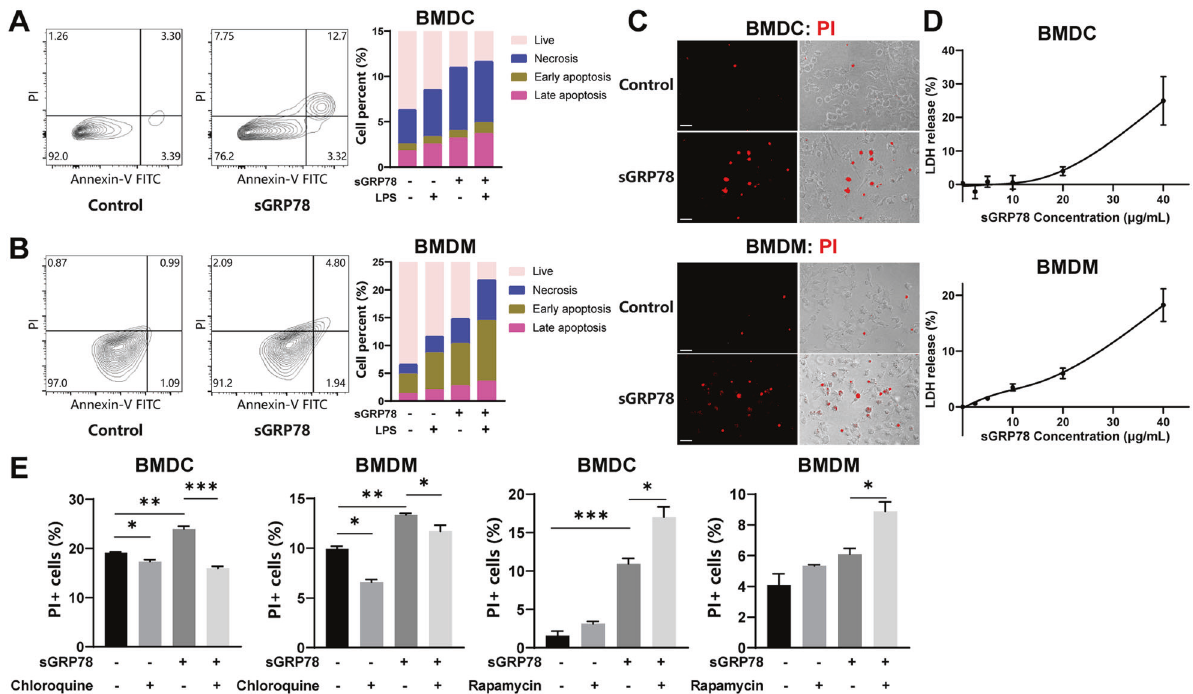
Fig. 6 sGRP78 promotes autophagy-dependent death of myeloid cells. BMDCs ( A ) and BMDMs ( B ) were treated with LPS or Grp78 for 24 h followed by AnnexinV/PI staining, C PI staining (Scale bar = 10 μ m) and D LDH release assay. E Cells were treated with LPS, Grp78, rapamycin (10 nM), or chloroquine (10 μ M) for 24 h. Then cell death was assessed through PI staining by FCM. Data are mean ± SEM from three independent experiments. * P < 0.05, ** P < 0.01, and *** P <